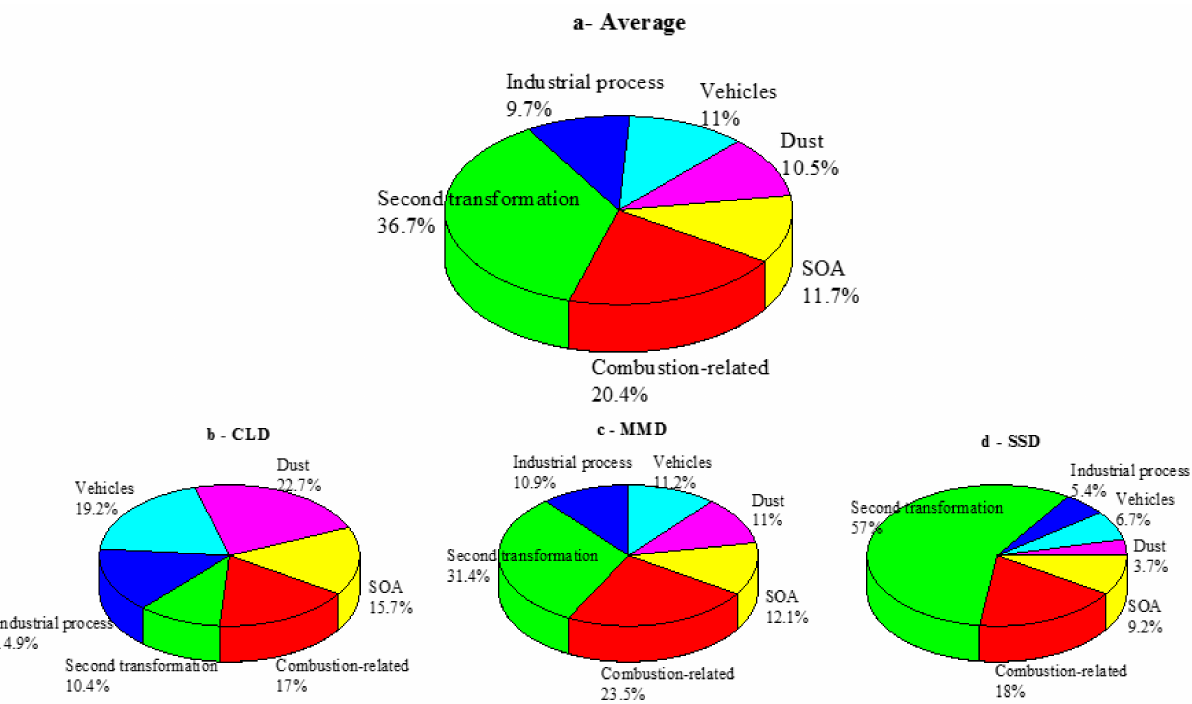
Figure 9. Sources proportion of different pollution levels to PM 2.5 in autumn and winter in